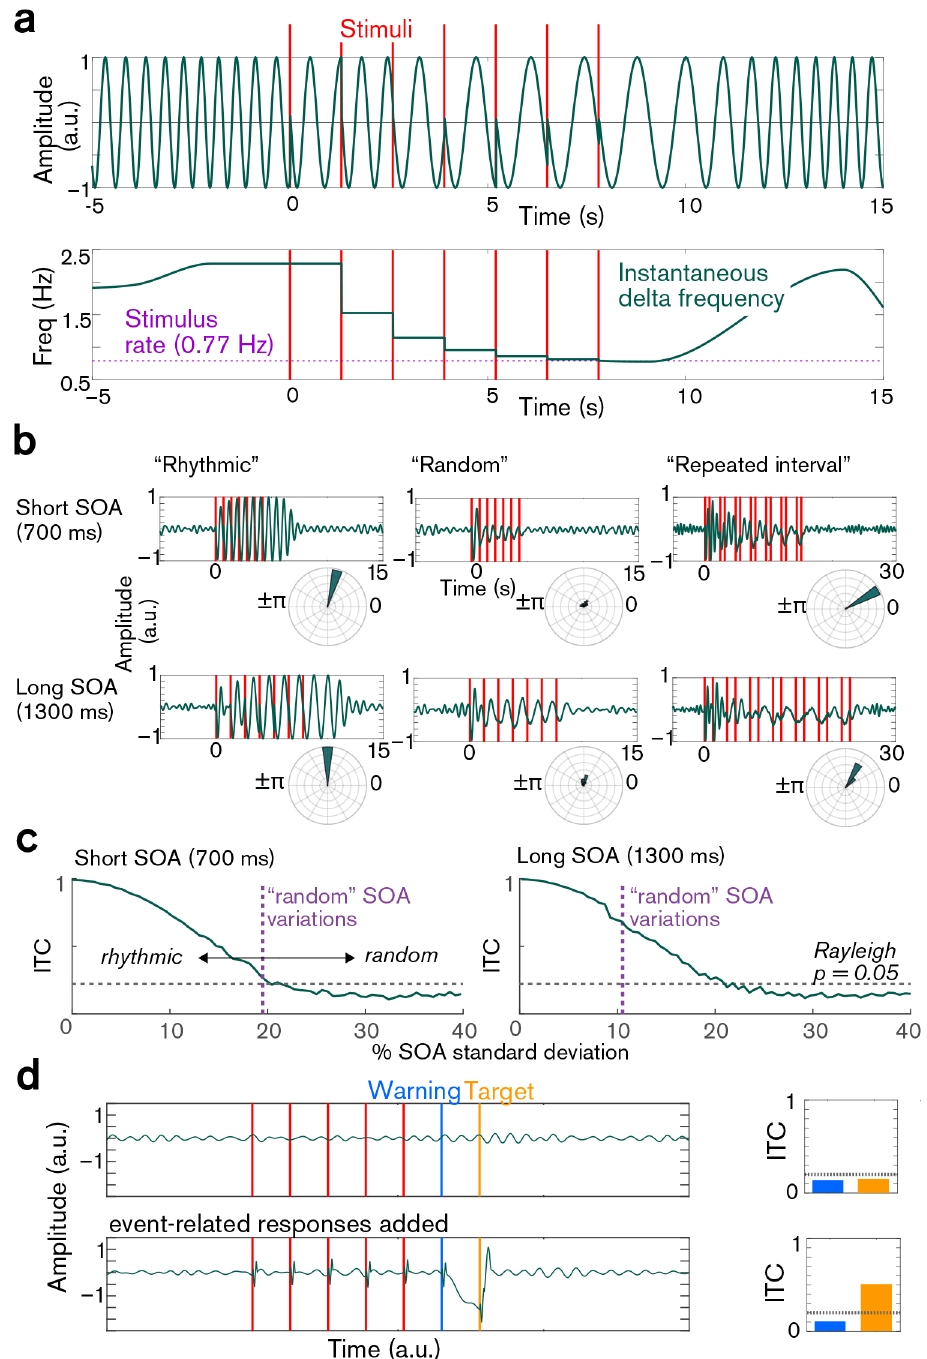
Fig 1. Pitfalls of “oscillatory investigations” into rhythm processing. (a) A 20-second-longsnippetof simulateddelta oscillationillustrating the propertiesof the model used to investigate the effects of task structure on the delta inter-trialcoherence measure. The top trace shows a simulatedongoingdelta oscillation that becomes entrainedby the stimulus onsets, indicatedby vertical red lines. The bottom trace is the time course of the instantaneous frequency of the delta oscillation; the horizontalline marks the stimulus rate. The ongoingoscillationhad a default mean frequency of 1.7 Hz (with a 20% standarddeviationof 0.34 Hz; Gaussianfrequencydistribution).Upon stimulus presentation, the oscillationwas reset, and the periodwas sequentially adjustedto the frequency halfway betweenthe current ongoingfrequencyand the SOA of the preceding 2 stimuli. (b) Simulated oscillatory entrainment by the stimulus structures employedby Breska and